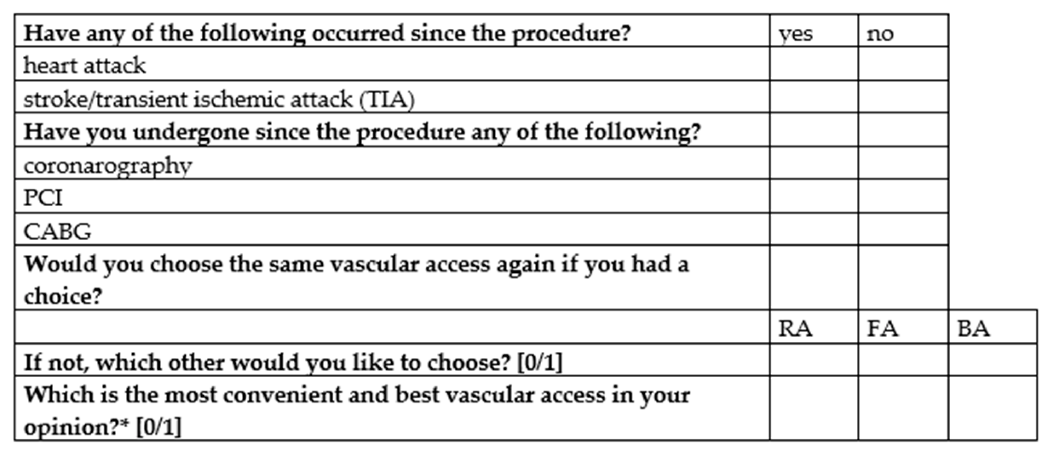
Figure 1. A proprietary telephone questionnaire assessing long-term complications of the procedure and the patient’s personal preferences regarding vascular access. * a question for patients who underwent procedures with the use of more than one access, CABG—coronary artery bypass grafting, PCI—percutaneous coronary intervention.